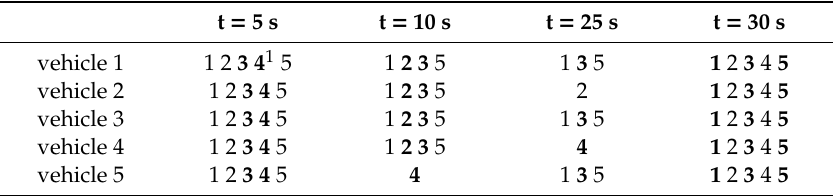
Table 2. Model Distribution (estimated vehicle) for each vehicle.